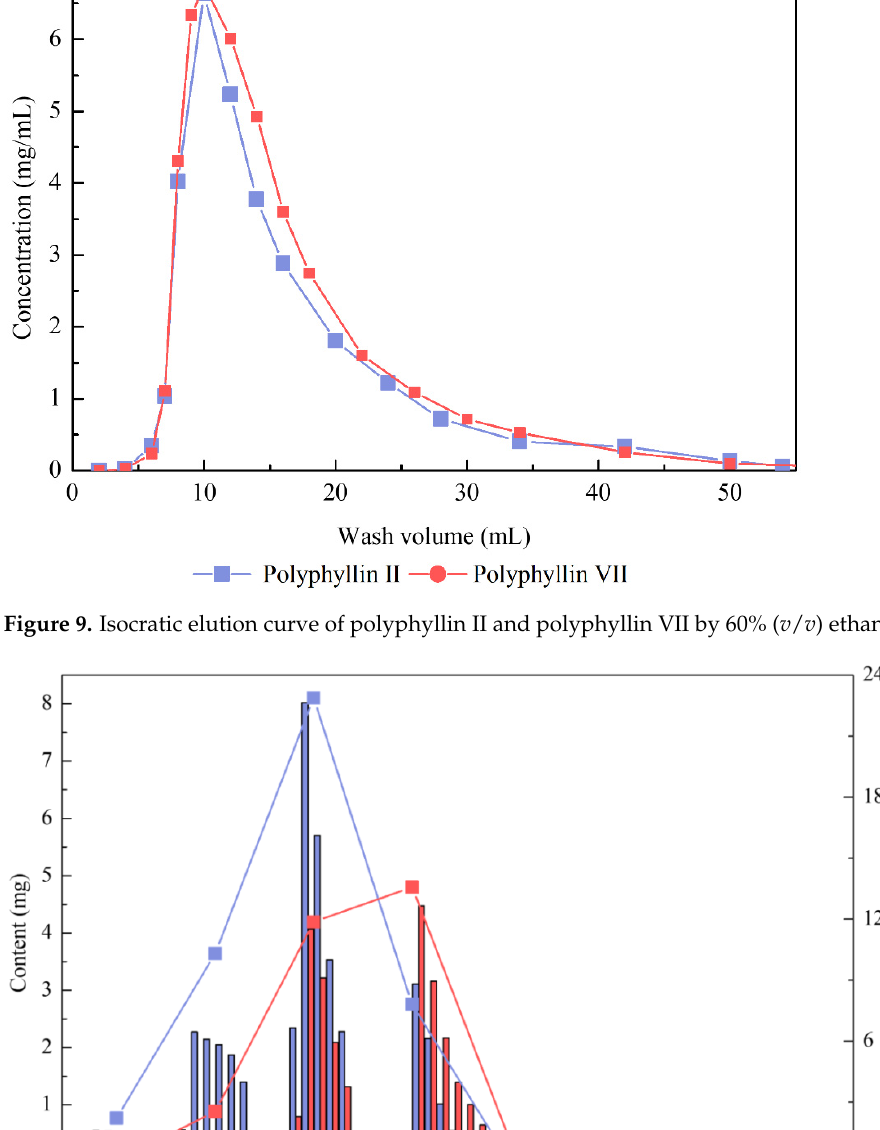
Table 9. Results of the optimization elution method for the two saponins.